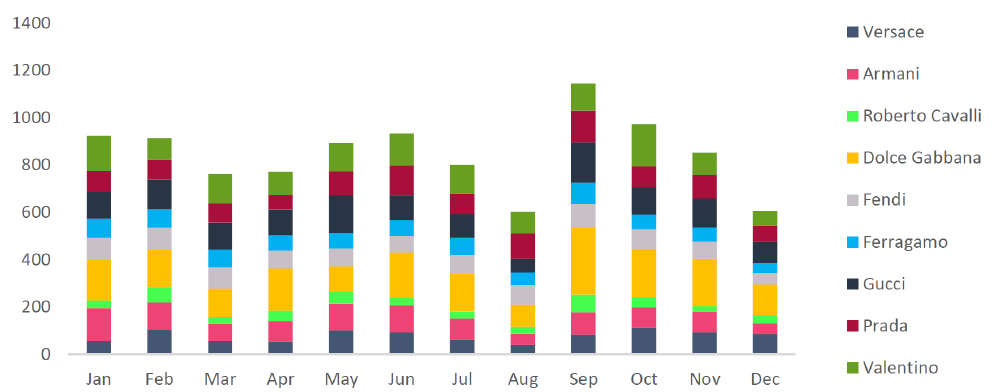
Figure 3. Post frequency per month by each